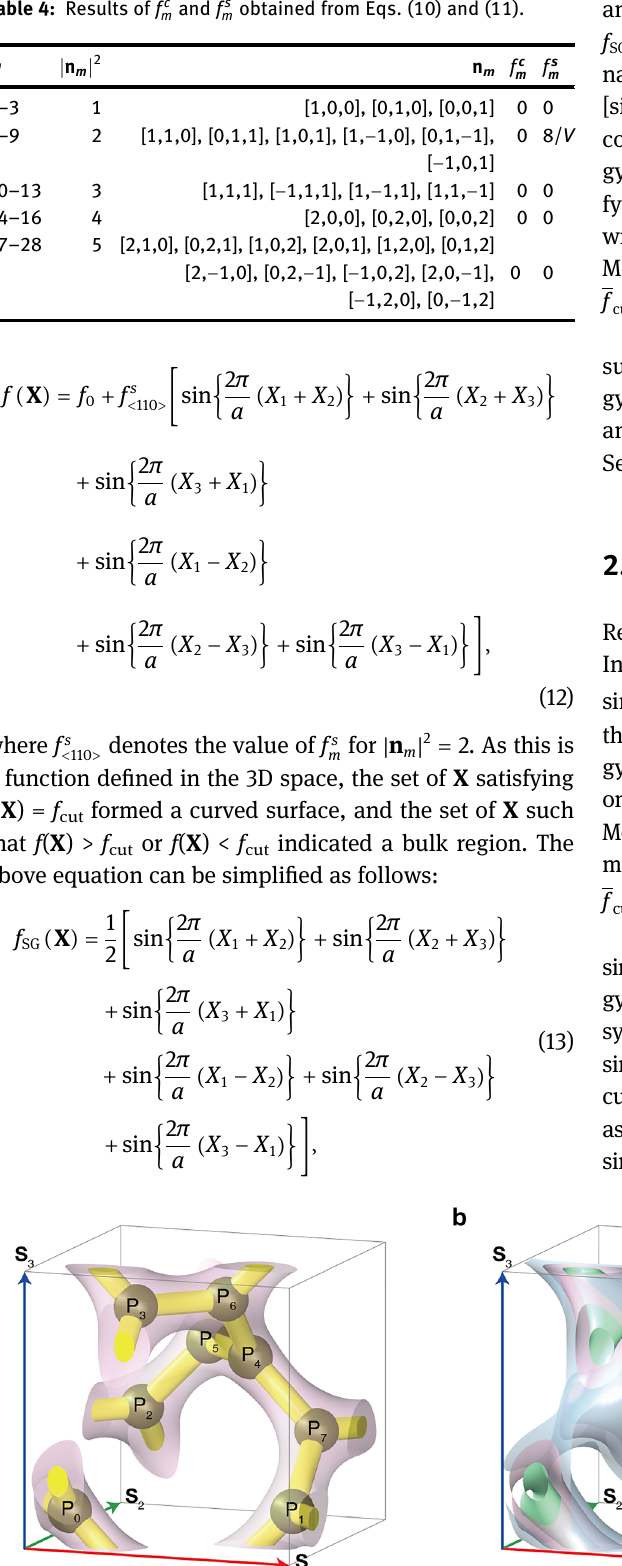
Table  : Results of f c